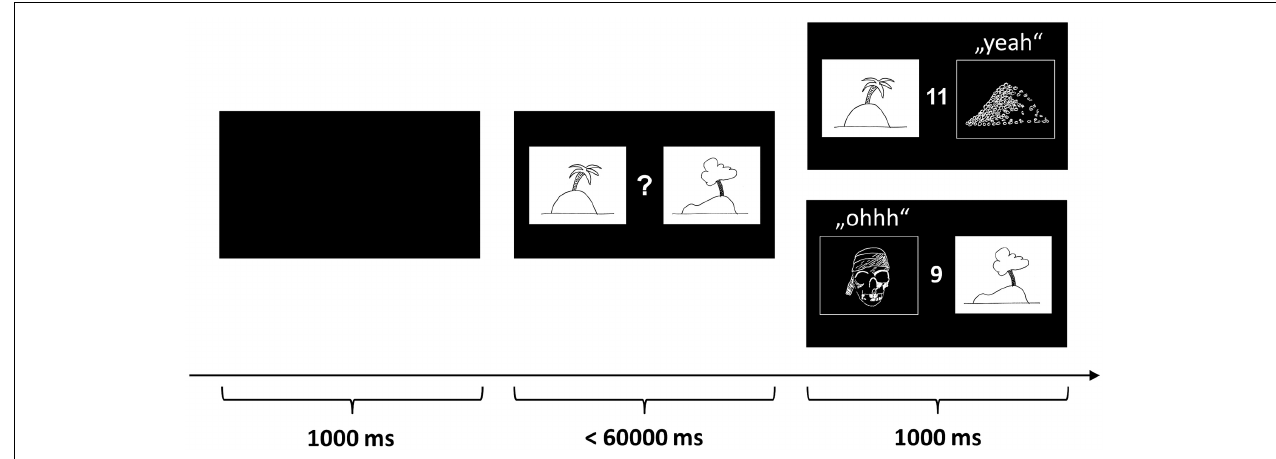
FIGURE 1 | Probabilistic reward-learning task (“pirate game”). The figure depicts one of 33 learning trials in each block. In each trial, two pictures of islands are presented and the participant has to decide which island to explore. If the “correct” island is chosen, the picture of the island is replaced by a picture of a treasure, a sound of children cheering “yeah” is played, and the treasure counter turns green and increases by one (reward). If the “wrong” island is chosen, the island is replaced by a jolly roger, a disappointed voice uttering “ohhh” is played, and the treasure counter turns red and decreases by one (punishment). The participants were instructed to learn by trial and error to approach the island on which a treasure is hidden more often and to avoid the island which is inhabited by pirates more often. The pictures above are merely symbolic. The actual pictures were color photos sampled from the